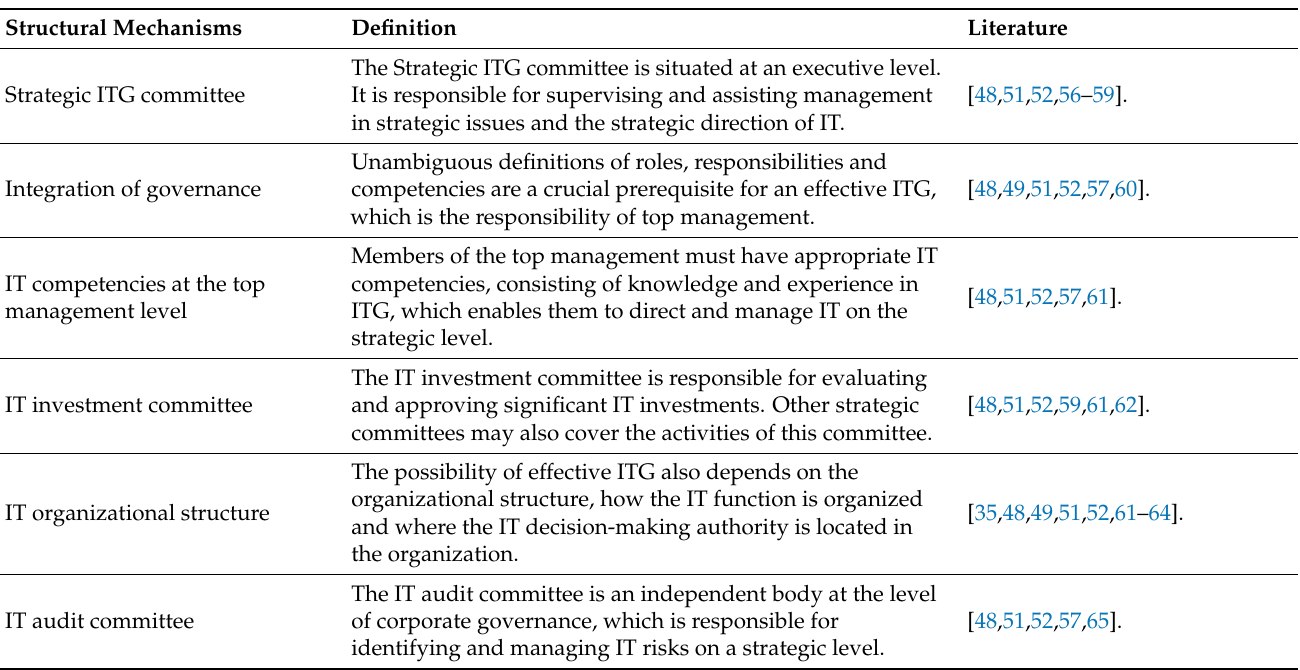
Table 1. Strategic ITG structural